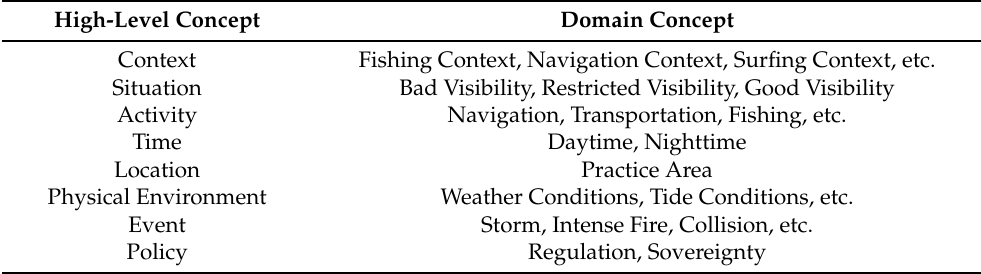
Table 3. Some domain concepts describing a context of on-demand nautical